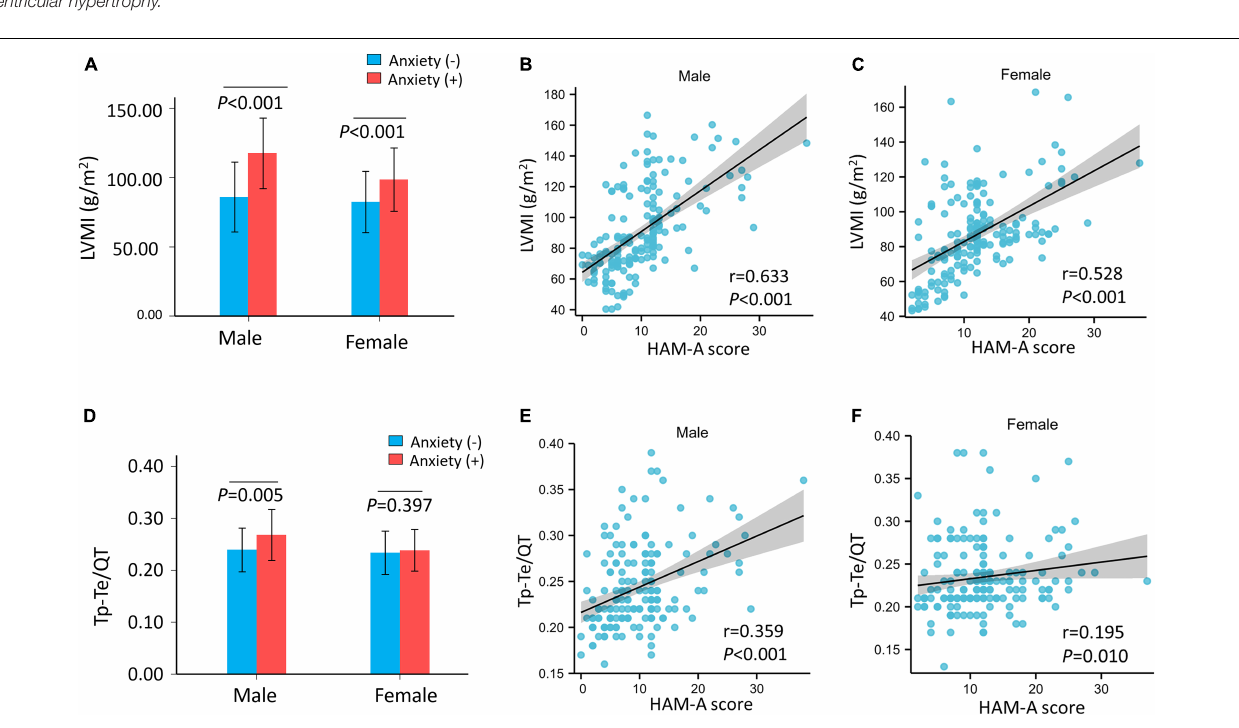
FIGURE 2 | The LVMI and Tp–Te/QT ratio of hypertensive patients and correlation with HAM-A score after stratified by sex. (A) The LVMI was significantly higher in hypertensive patients with anxiety than hypertensive patients without anxiety both in male ( p < 0.001) and female ( p < 0.001). (B,C) HAM-A score was